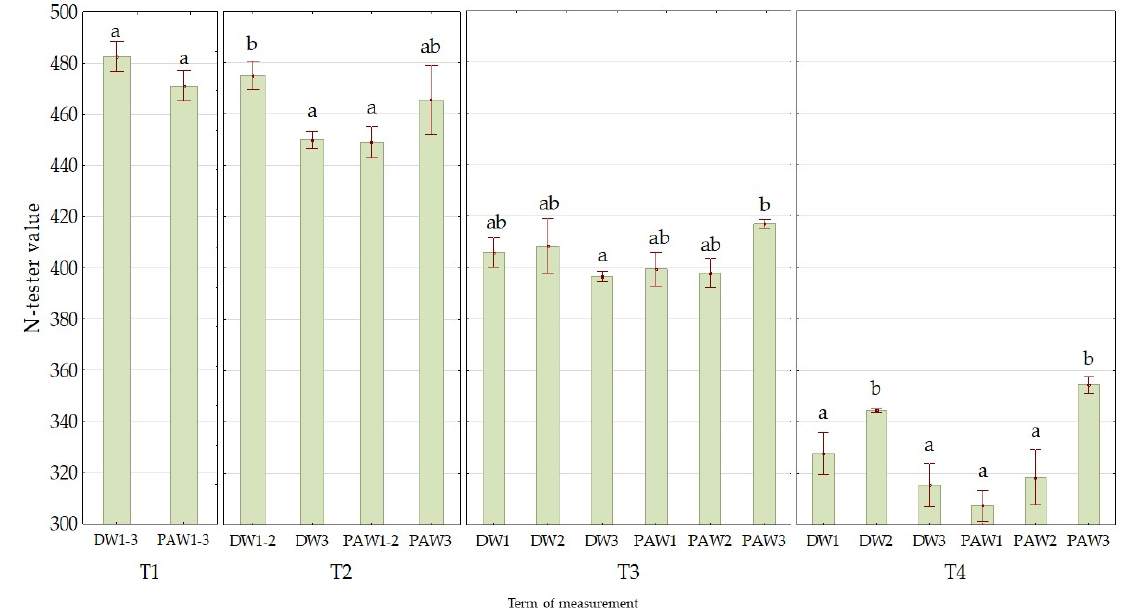
Figure 2. The effect of PAW application on chlorophyll contents (N tester value) over time. The mean values (n = 60) sharing the same lowercase letter are not significantly different from each other ( p ≤ 0.05) according to the LSD test (each term was evaluated separately). Intervals present the mean standard error (SE).